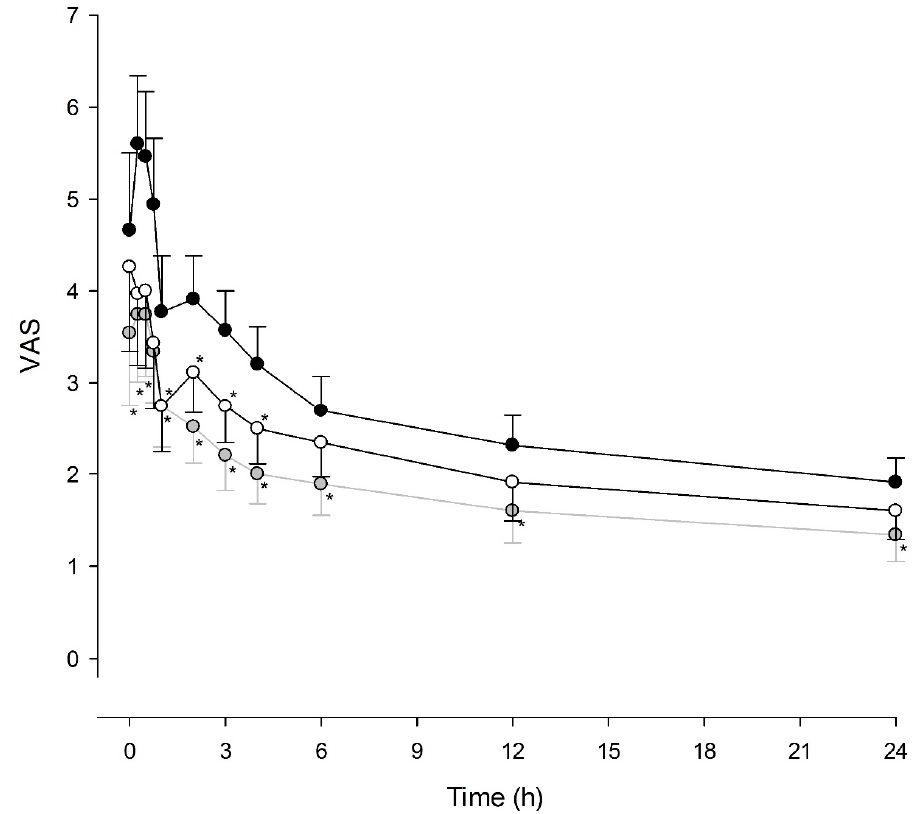
Figure 2. Time-courses of the visual analogue pain rating scale (VAS) scores during the postoperative analgesia. CRBI group (black circle), fentanyl patient-controlled analgesia (PCA) with constant rate background infusion (BI); TDBI group (white circle), fentanyl PCA with time-scheduled decremental BI; POBI group (grey circle). The circles and whiskers indicate means and 95% CI. * P < 0.05 compared with CRBI group.